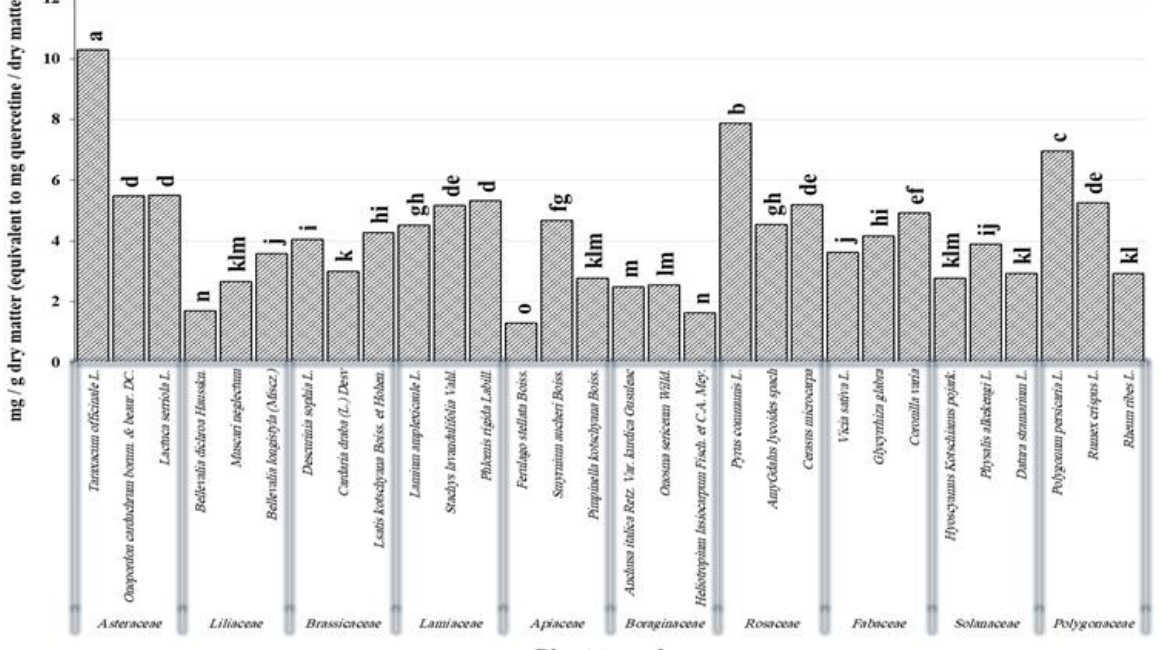
Fig. 12. Mean value of flavonoid of plant species affected by plant